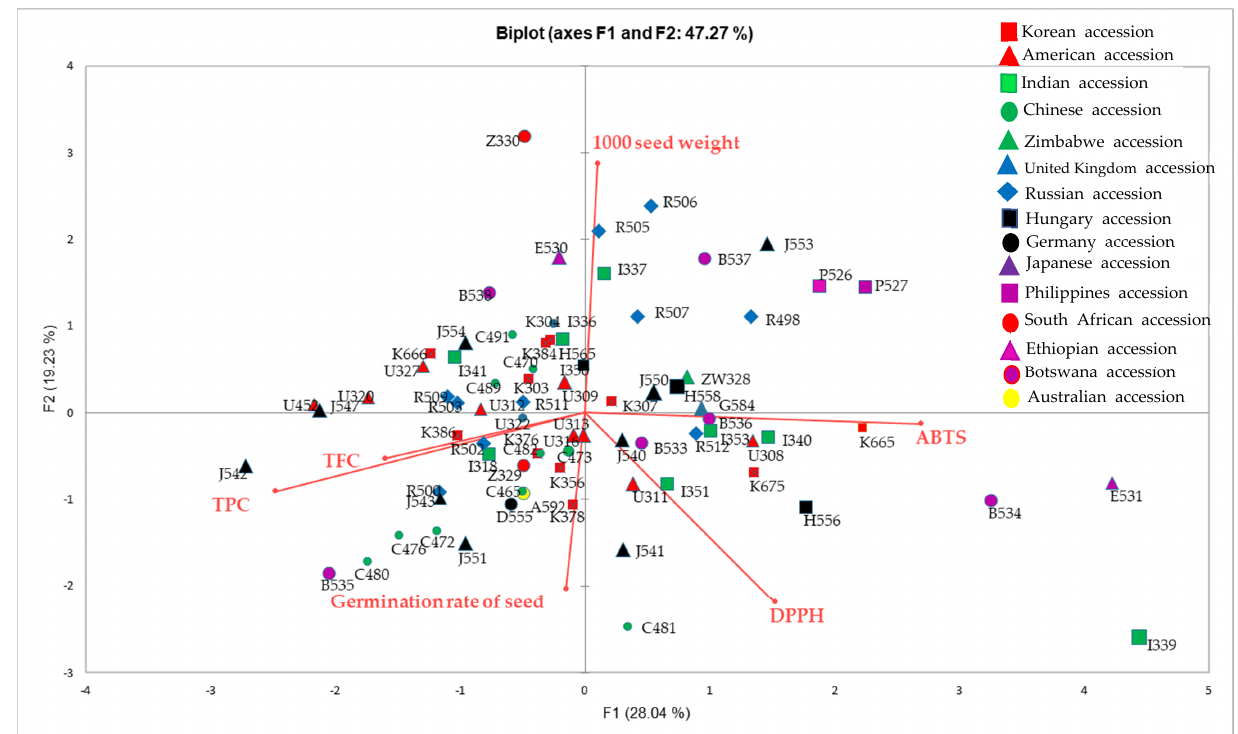
Figure 3. Principal component analysis (PCA) biplot constructed by plotting the PC1 (vertical axis) scores against the PC2 (horizontal axis) scores obtained from seed characteristics, antioxidant activity, and total phenolic and flavonoid content.